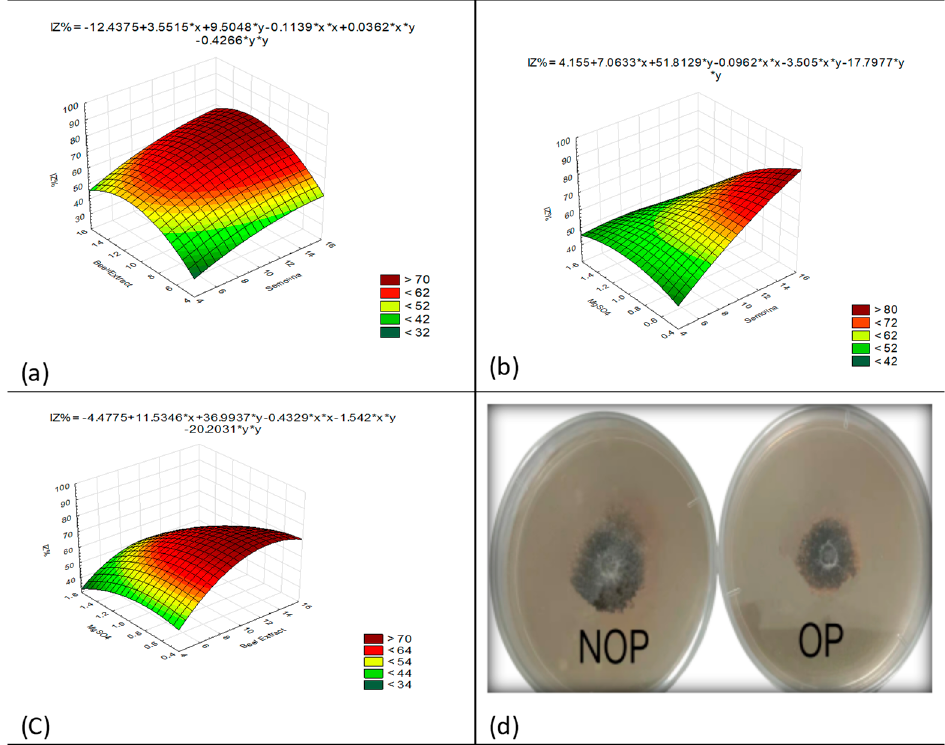
Figure 3. Response surface plots of the effect of various factors on the inhibition rate of C. arachidichola